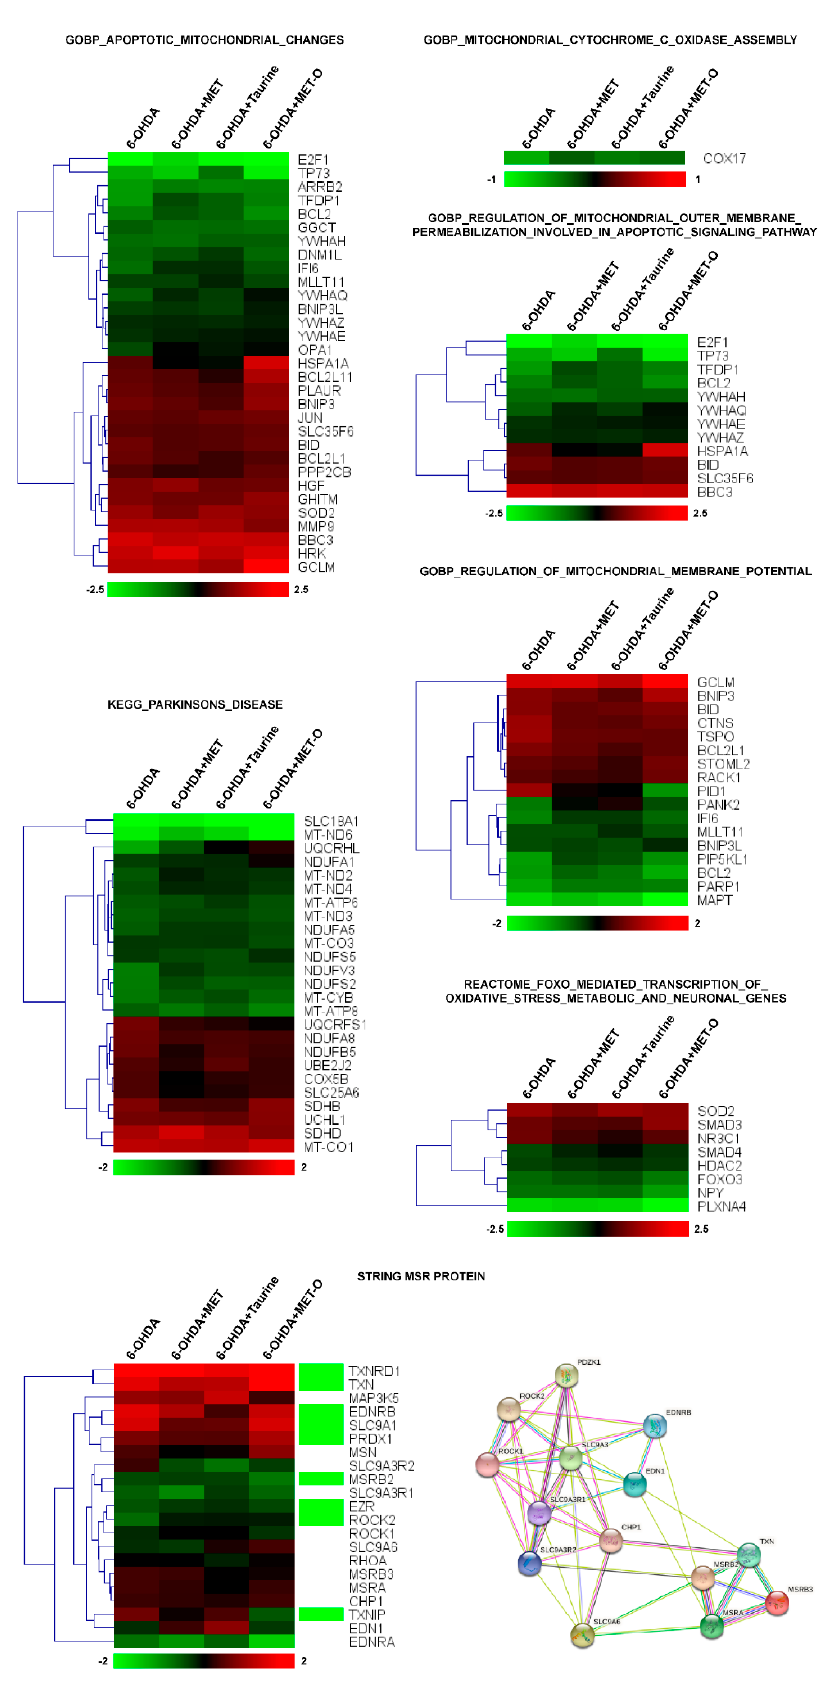
Figure 3. Heatmap of hierarchical clustering of the selected pathways. All the genes of the pathway that are significantly affected by 6-OHDA (adjusted p < 0.05) are reported in the heatmaps. Green